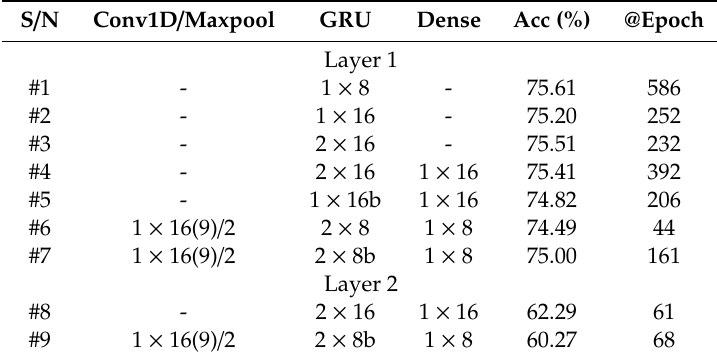
Table 2. Model validation